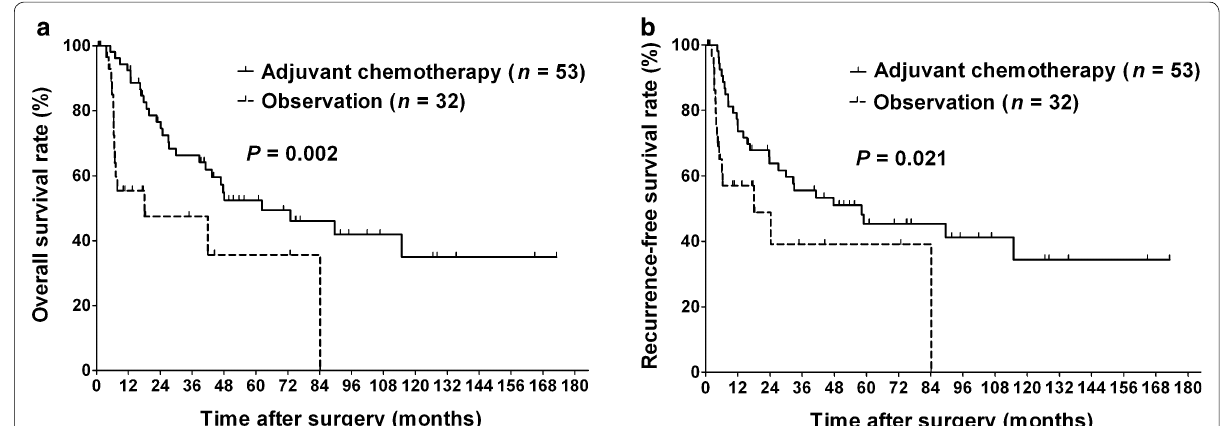
Fig. 1 Kaplan–Meier survival curves of patients with stages II and III biliary tract cancer after microscopically margin‑negative resection in the fluoropyrimidine‑based adjuvant chemotherapy and observation groups. a Overall survival. b Recurrence‑free